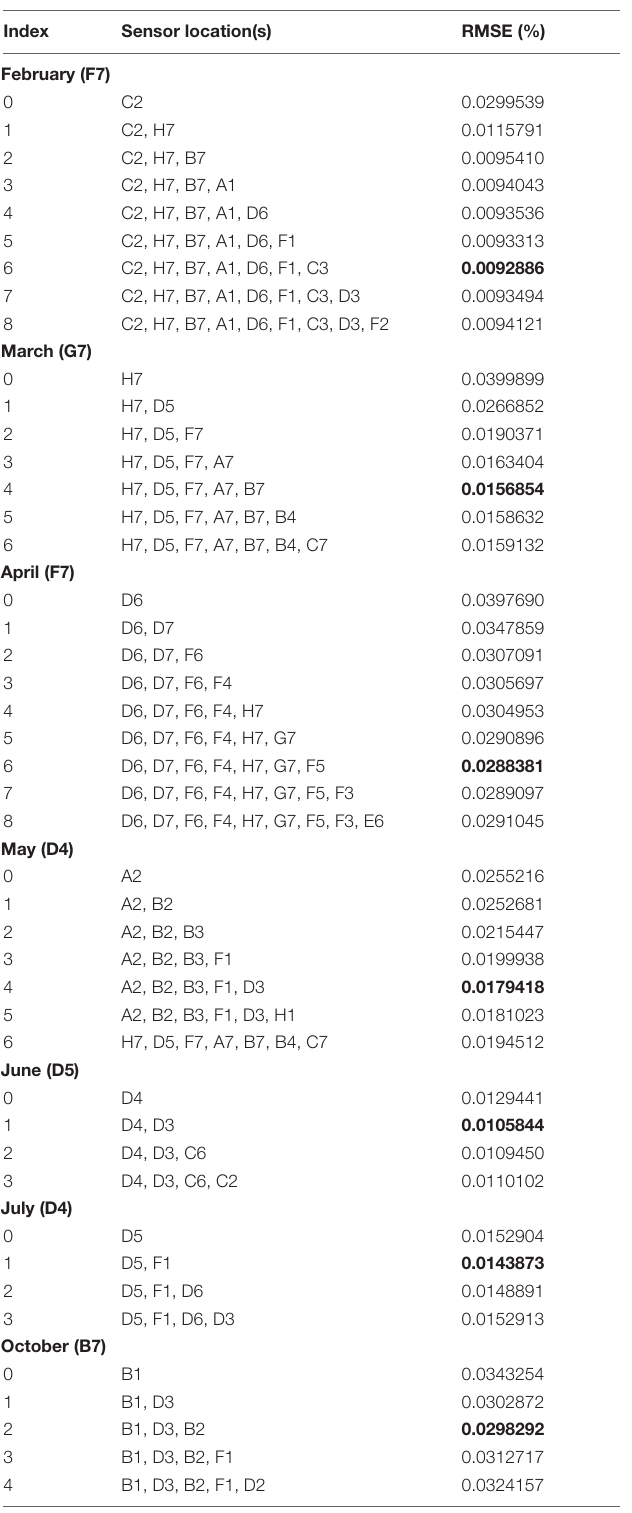
TABLE 3 | Performance of sensor network in identifying the optimal number of sensors and placement for measuring greenhouse conditions across different months using relative humidity